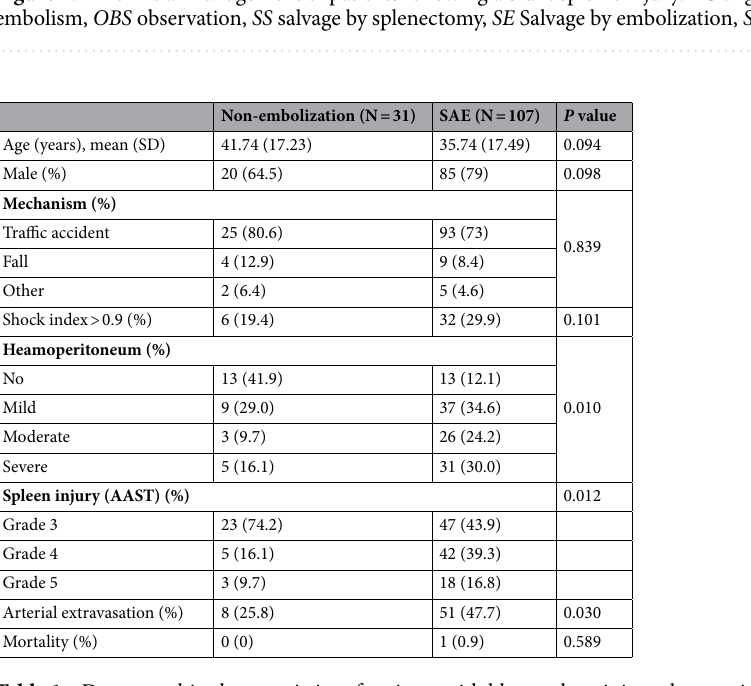
Table 1. Demographic characteristics of patients with blunt spleen injury that received NOM. AAST American Association for the Surgery of Trauma, NOM non-operative management, SAE splenic artery embolization SD standard